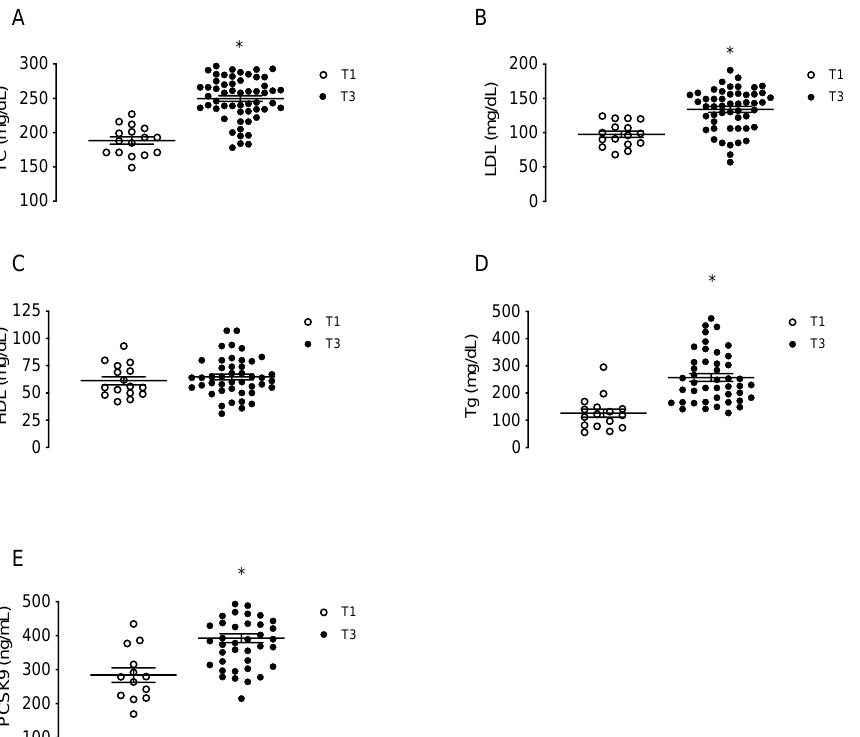
Figure 1. Maternal concentrations of lipids and PCSK9 at first and third trimesters of pregnancy. Total cholesterol (TC, ( A )), LDL ( B ), HDL ( C ), triglycerides (Tg, ( D )) and circulating levels of PCSK9 ( E ) were determined in serum from MPH pregnant women at first (T1, n = 16, white) and third trimesters (T3, n = 44, black). Values are mean ± S.E.M. * p < 0.05 versus values for T1.